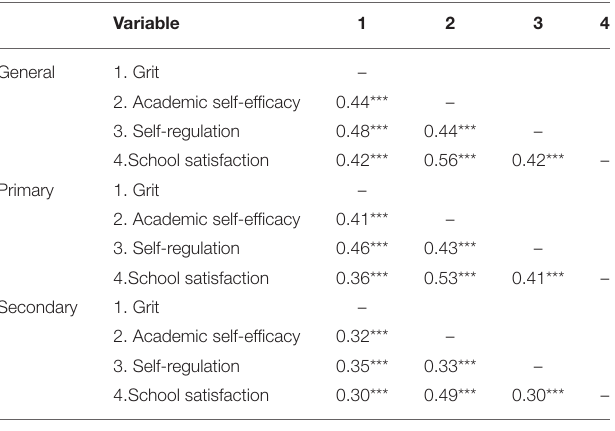
TABLE 3 | Correlations between variables at a general level and by educational level.